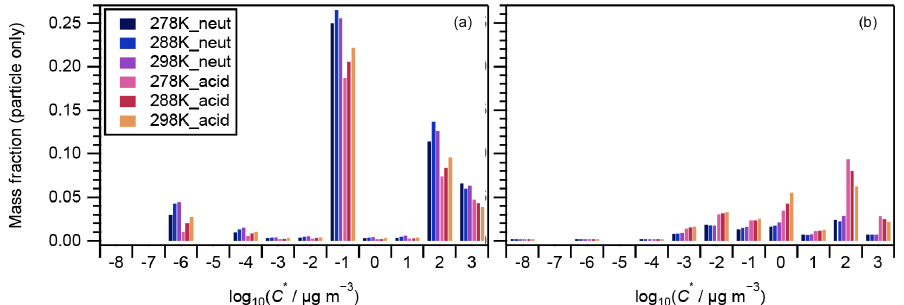
Figure 7. Volatility distribution of SOA compounds whose particle-phase mass fractions under acidic seed conditions were (a) less than 0.9 and (b) more than 1.1 times those of neutral seed conditions. Note the mass fractions presented here are the same as those in Fig. 4a.